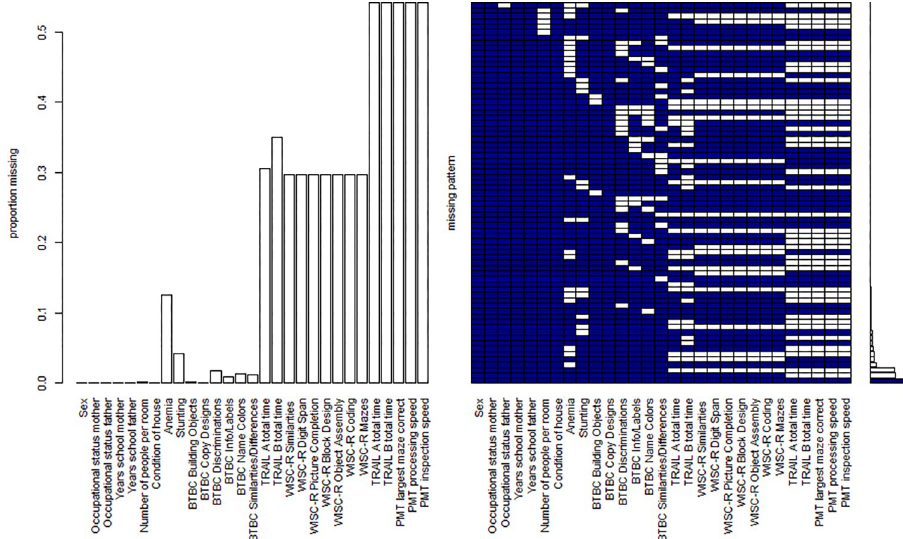
Fig 2. Missing data pattern for variables included in the analysis. The bar chart on the left depicts the proportion of data missing for each variable. The graph on the right displays the different data patterns, with missing data in white and available data in blue. The histogram shows the frequency of the individual data patterns, with complete cases accounting for 28.0% of the total sample.